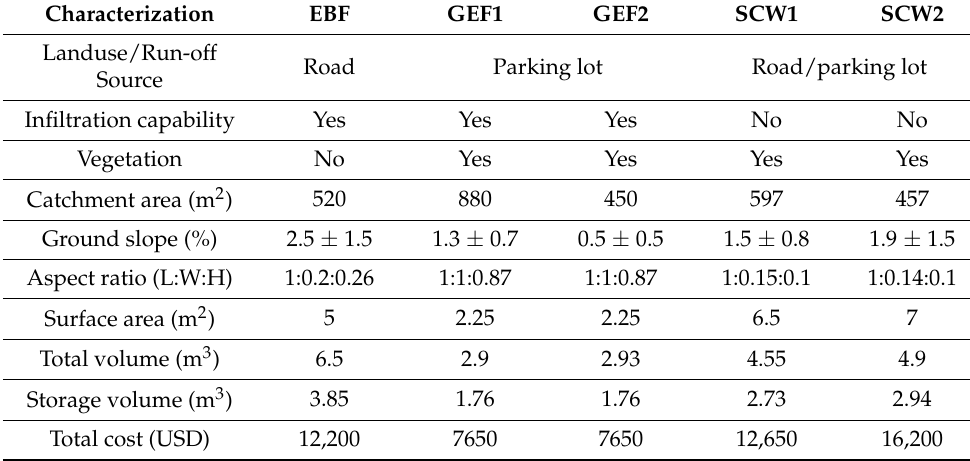
Table 2. Bioretention